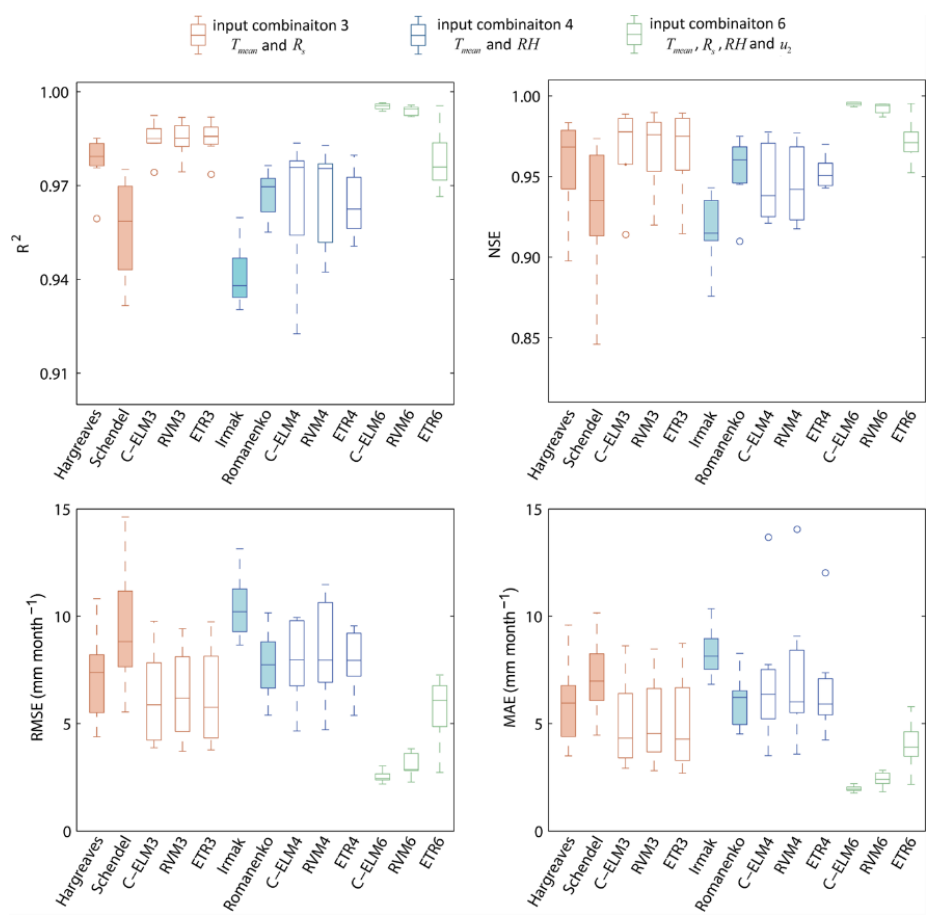
Figure 7. Boxplot of statistical indices for the four empirical equations and ML models for predicting ET 0 with input combinations 3, 4, and 6. Solid boxes are empirical equations, and blank boxes are ML models.